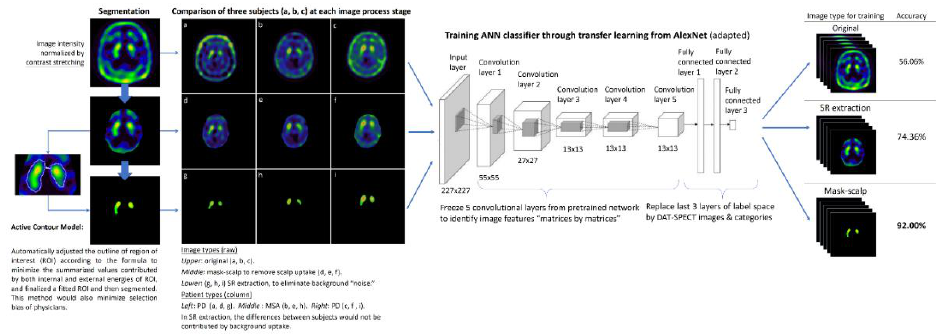
Figure 2. Workflow of image preprocessing, SR segmentation, and ANN classifier training. The ANN classifier was trained by different types of images (original, whole brain, and segmented SR). The SR segmentation demonstrated higher accuracy than the other two types of images.